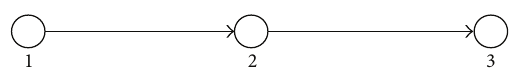
Figure 5: An illustration of a simple transportation